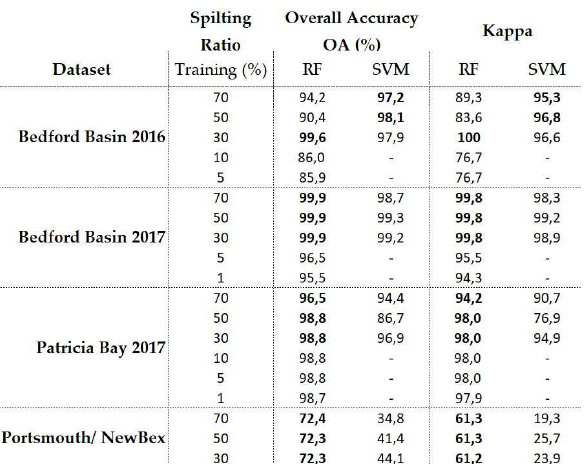
Table 4: Comparing the derived OA and Kappa from